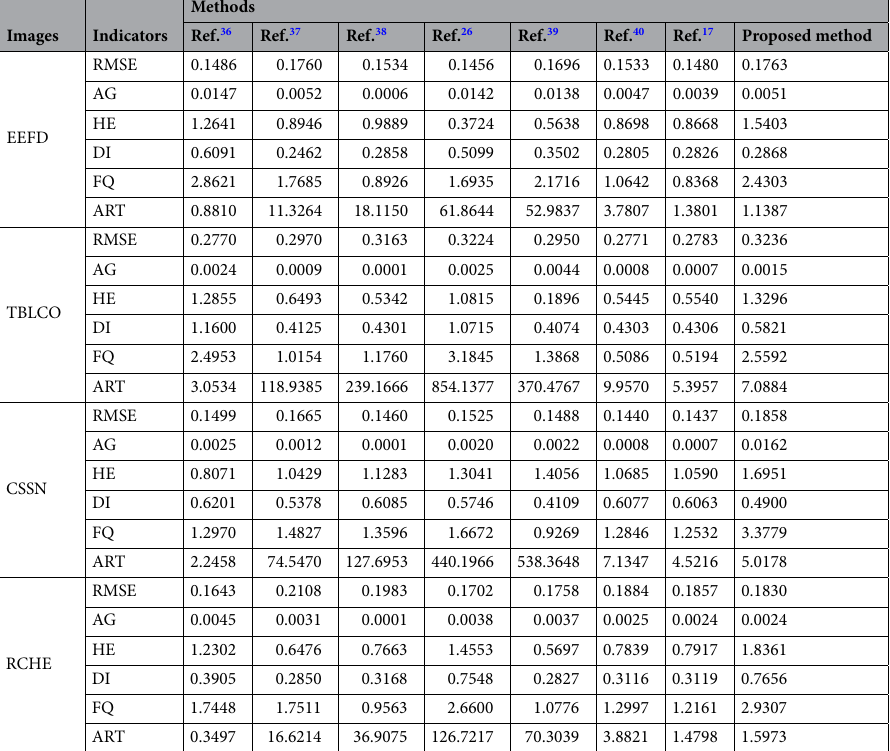
Table 1. Performance indicators of different algorithms under four types of source